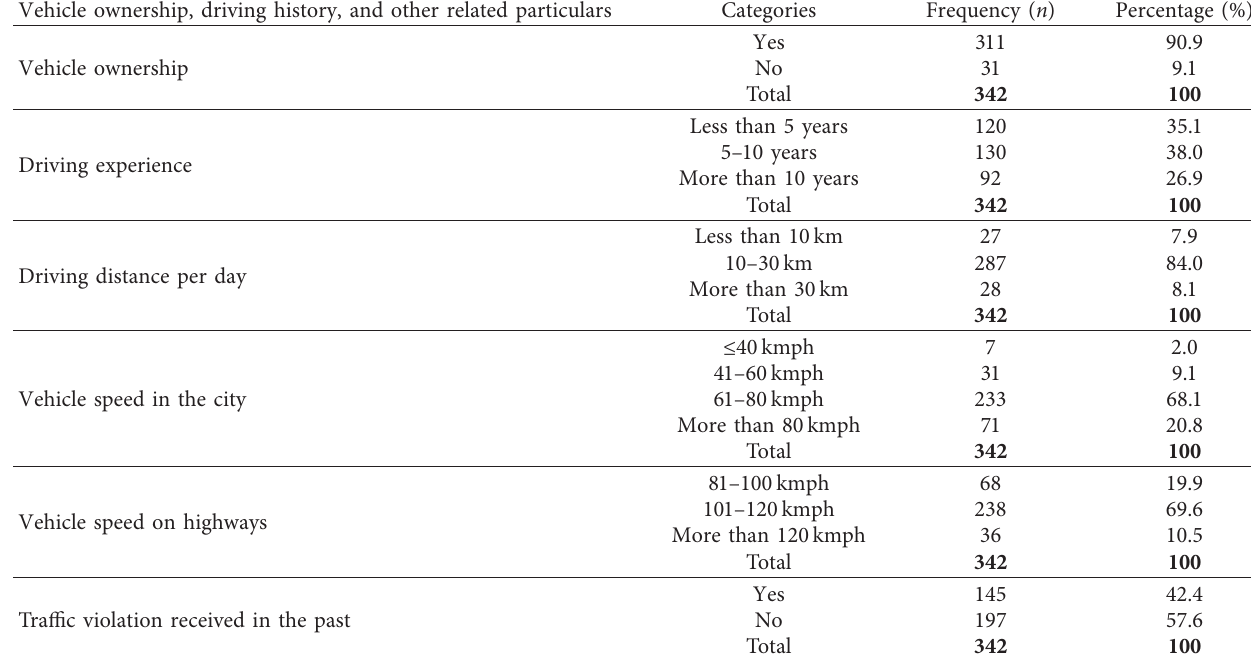
Table 2: Vehicle ownership, driving history, and other related particulars ( n �